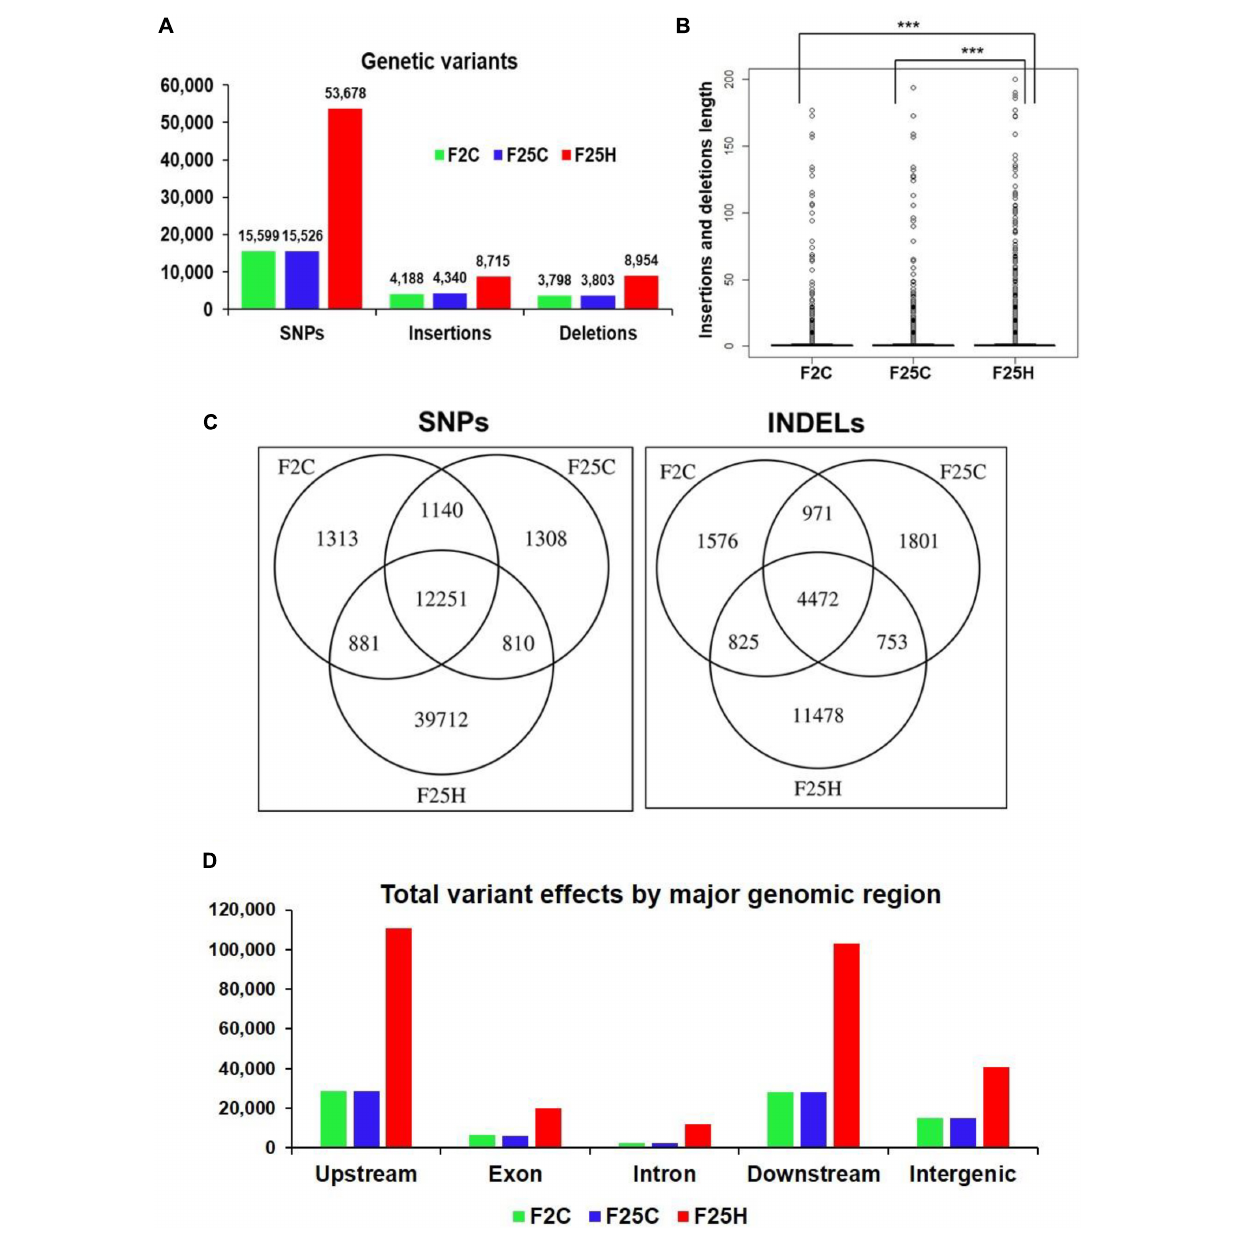
FIGURE 2 | The heat-stressed progeny showed a higher number of genetic variations (with relaxed parameters). (A) The total number of SNPs and INDELs in the genomes of stressed progeny and in the parallel and parental control progenies when all samples were jointly considered. Genomic variants consisting of SNPs and INDELs were determined by mapping and comparing F25H, F2C, and F25C sequencing reads to TAIR 10 reference genome. (B) The box plot for the length of insertions and deletions of variants within F2C, F25C, and F25H. The asterisk above bracket (*) shows a significant difference between F25H vs. F2C and F25H vs. F25C where *** indicates p < 0.001. Wilcoxon rank-sum text was used to determine a statistical difference ( p < 0.05). (C) A Venn diagram of jointly called variants. The non-overlapping area of Venn indicates the number of unique SNPs and INDELs in each sample group. Sample variants were jointly called by the “GATK haplotype Caller” using five samples together. (D) The total number of variant effects by major genomic regions. The number of variant effects in the major genomic regions are shown above each bar, and the genomic regions are indicated on the x